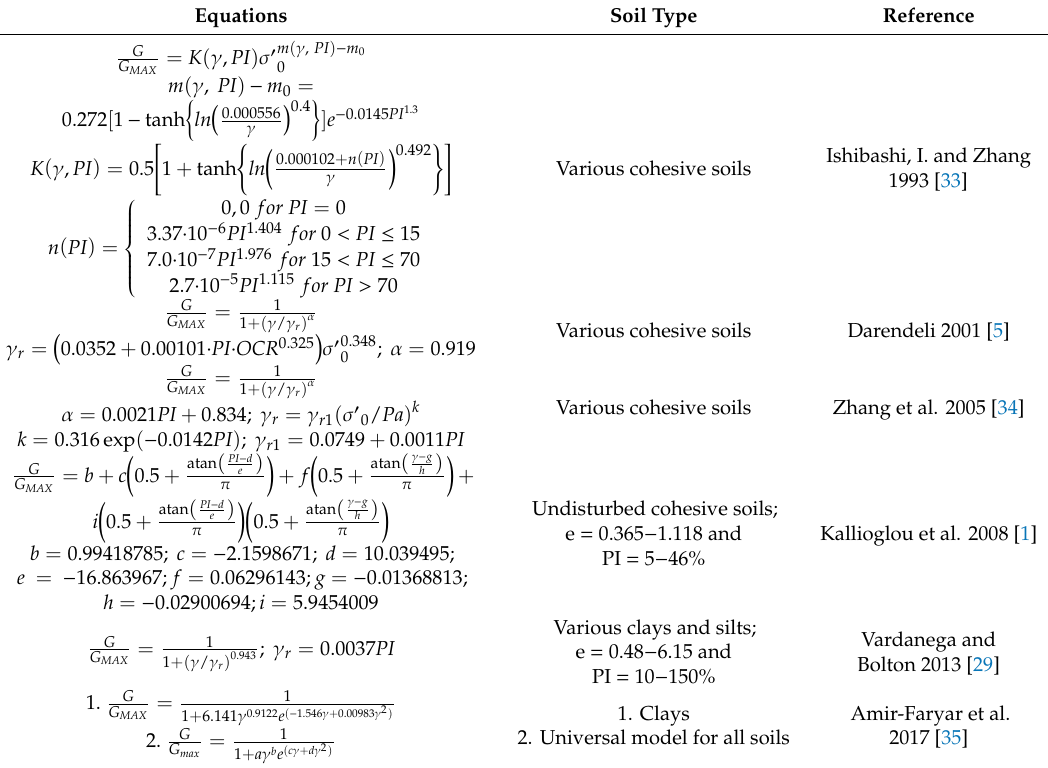
Table 2. Relationships for G / G MAX of cohesive soils. Equations Soil Type